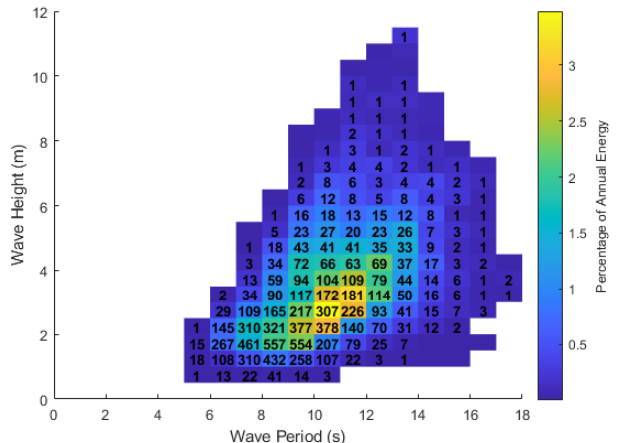
Figure 2: Omni-directional sea state histogram from 2000-2010 at PacWave, OR (mean annual conditions) In Los Angeles County in Southern California, the wave energy resource differs greatly from Oregon, and the most common and most energetic sea state combinations are one in the same: 1.25m at 8.5s (955hrs), as shown in Figure 3. Additionally, the maximum hindcast wave heights are just 40% of those experienced at PacWave.